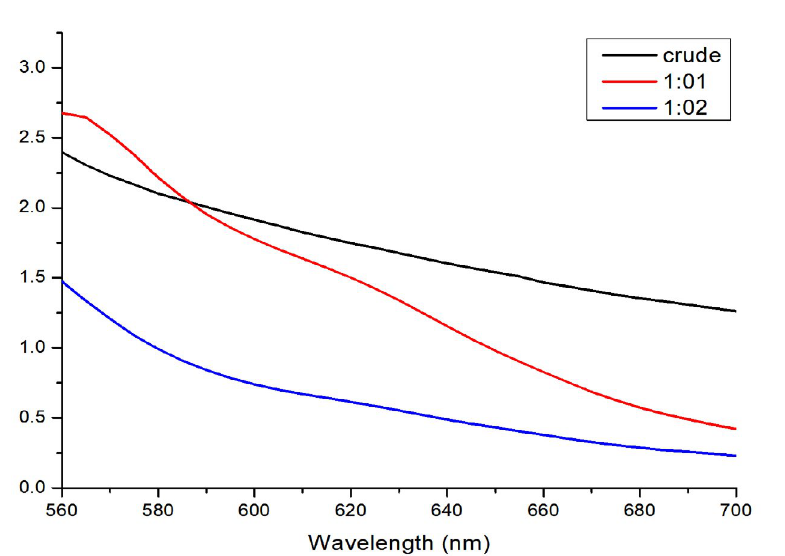
Fig. 1. UV-visible spectra of T. ammi extract solution and synthesized AuNPs Where, Crude: extract solution of T. ammi